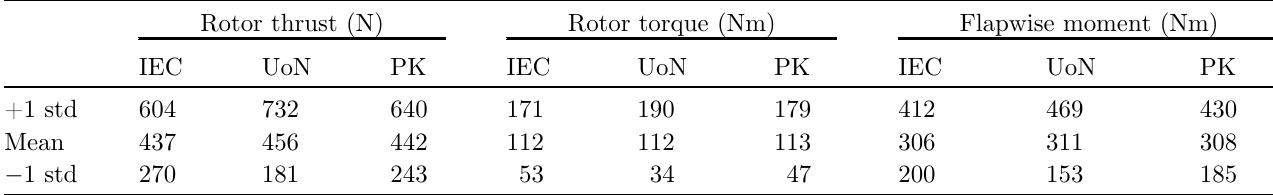
Table 2. Ten-min statistics for rotor thrust, torque, and blade load.